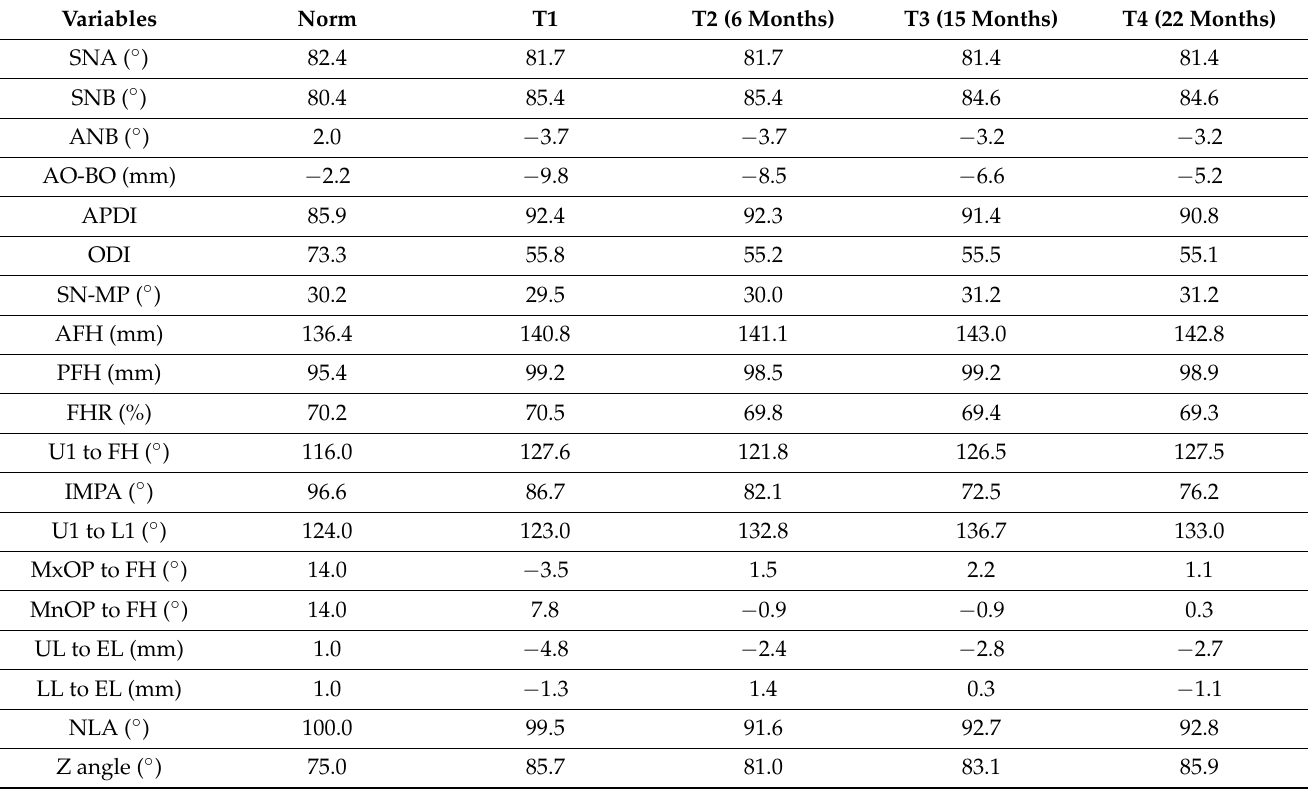
Table 1. Two-dimensional cephalometric